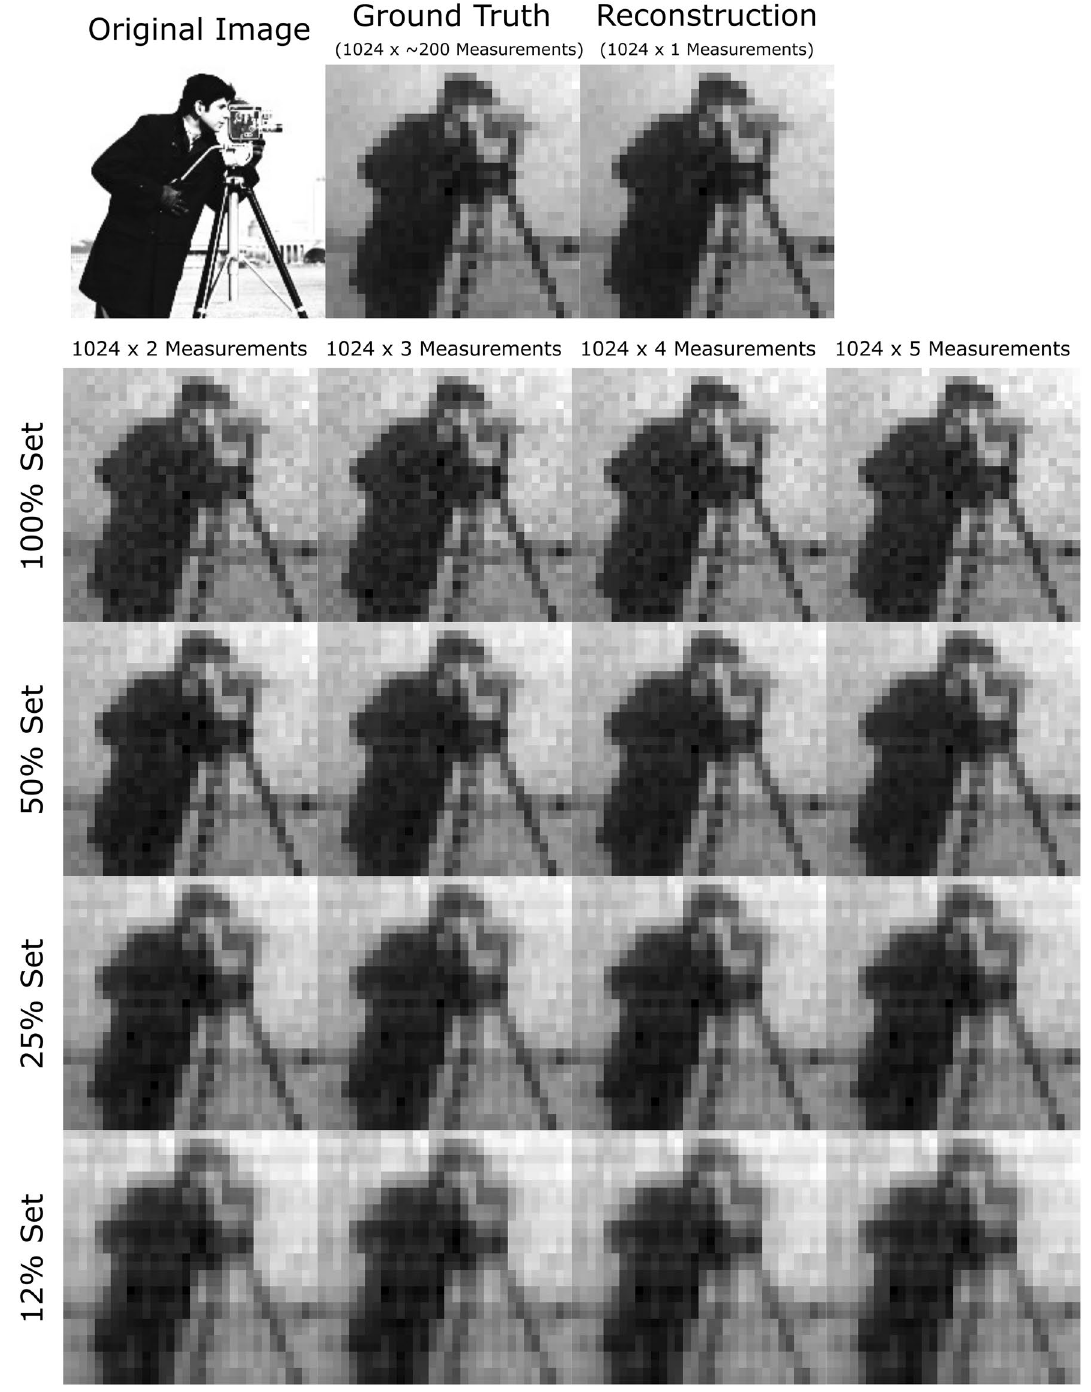
Figure 3. This illustration of compressed sensing uses the standard “cameraman” test image as an object in the experiment. The ground truth image obtained after ≈ 200 iterations of 1024 patterns is compared to reconstruction using 100%, 50%, 25% and 12% pattern subsets for up to 5120 measurements. The images here were acquired in a high SNR conditions corresponding to Fig. 4A. The “cameraman image” is adapted from the Massachusetts Institute of Technology, all rights